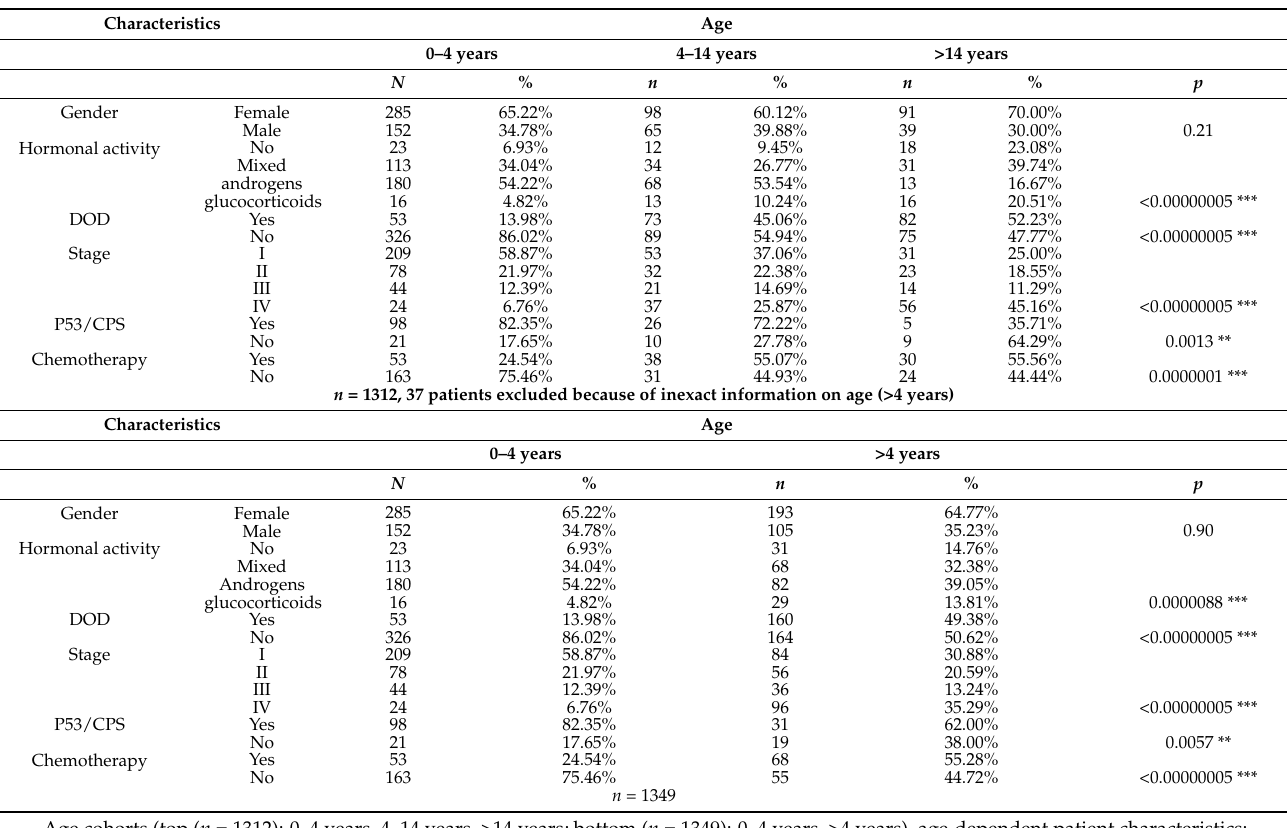
Table 3. Age-dependent characteristics of the 1349 pediatric patients with an adrenocortical tumor from the selected original publications identified by the systematic literature review.